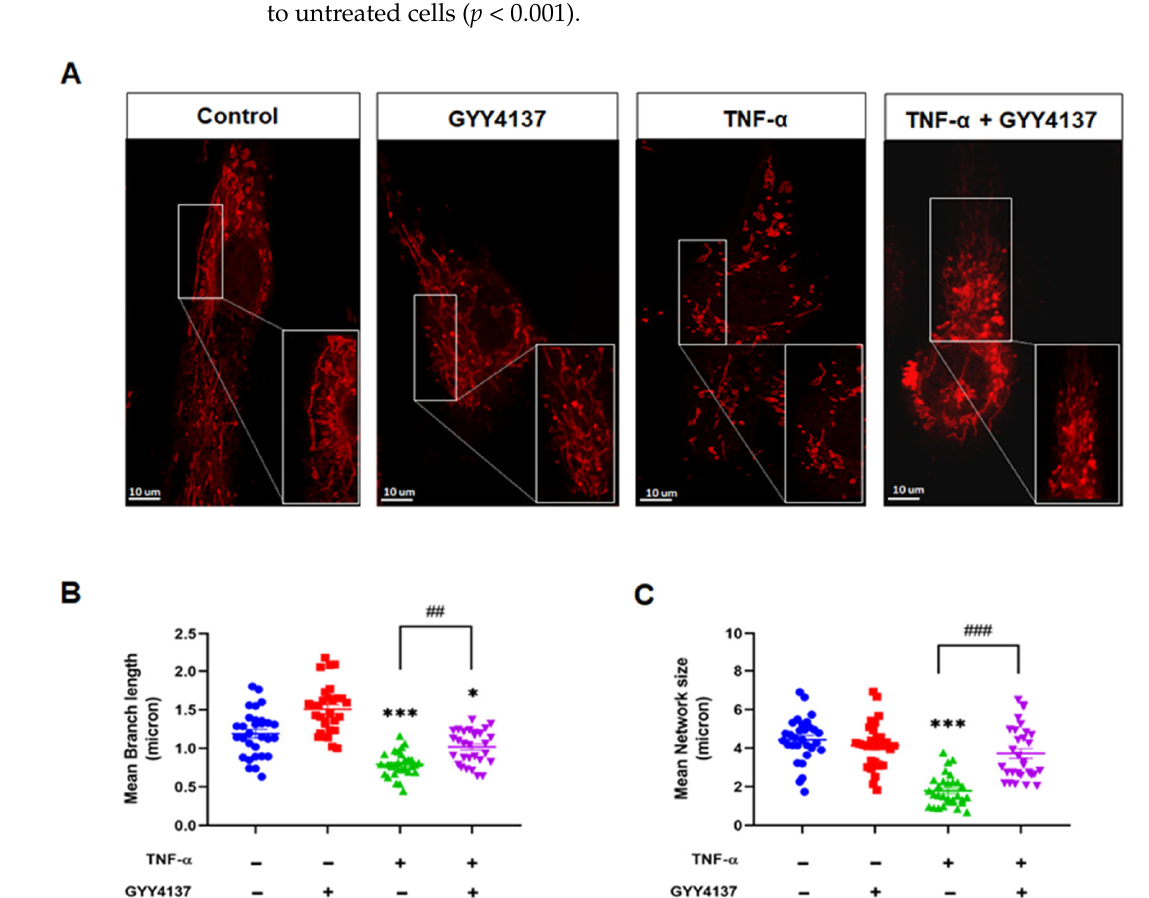
Figure 8. GYY4137 post-treatment prevents mitochondrial morphology changes mediated by TNF- α . ( A ) Mitochondria morphology was determined by Mitotracker (red staining, 100 nM) and confocal microscopy imaging (63 × oil APO objective lens). Images of isolated mitochondrial networks were analysed using a publicly available ImageJ macro, MINA [24]. Scale bar 10 μ m. ( B ) Mitochon ‐ dria mean branch length is the average length (in microns) of all branches. ( C ) Mitochondria net ‐ work size is defined as the average number of branches per network (in microns). p ‐ values were treatment group per independent experiment were consolidated and measured. Data are shown as